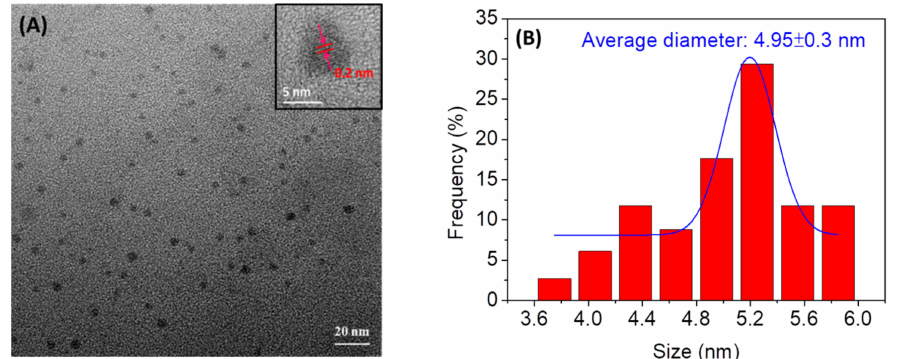
Figure 1. ( A ) TEM image and ( B ) particle size distribution of the as-fabricated N , Cl -CDs. The inset in the top right of Figure 1A is a magnified TEM image of an N , Cl -CDs